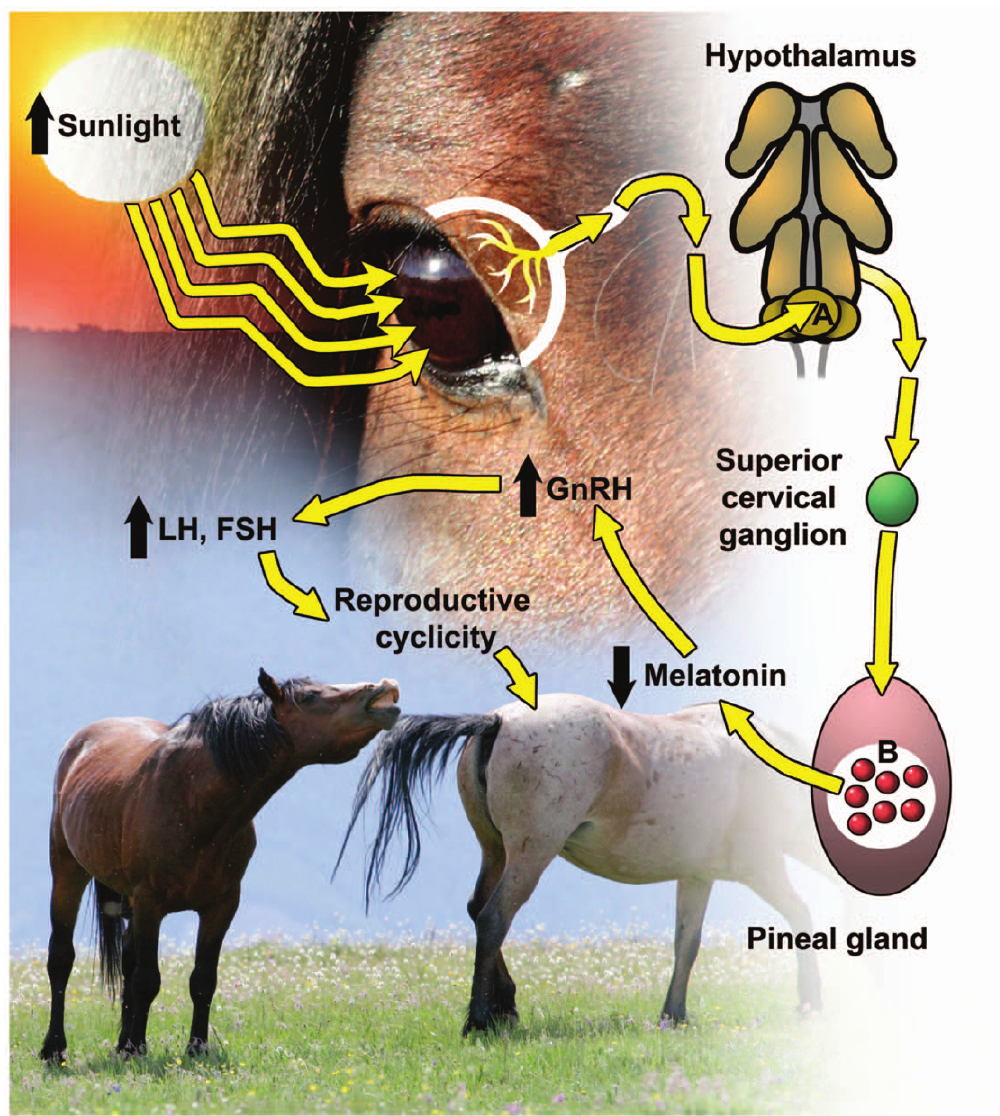
Figure 1. The physiological pathway from photoperiod to reproductive cyclicity in the horse ( Equuscaballus ). Increasing sunlight toward the long days of summer strikes the retina, which transmits a neural signal to the suprachiasmatic nuclei (A), across the hypothalamus, and ultimately synapses to the pineal gland to stimulate release of inhibitory neurotranmitters toward the pinealocytes (B). Melatonin production then diminishes, thus increasing release of gonadotropin releasing hormone (GnRH), which increases luteinizing hormone (LH) and follicle stimulating hormone (FSH), and ultimately induces reproductive cyclicity.